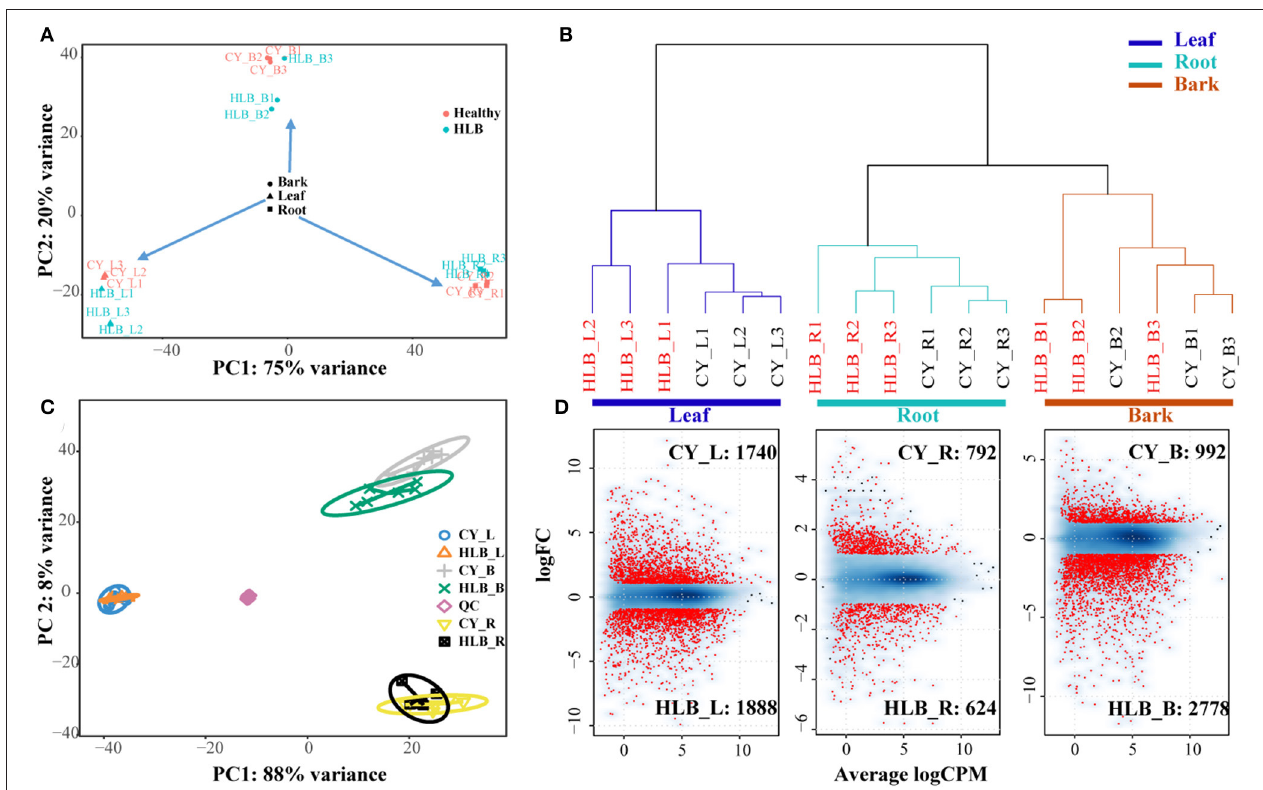
FIGURE 2 | Cluster analysis of all the differentially expressed genes (DEGs) and detected metabolites between C Las-infected and healthy tissues. (A) Principal component analysis (PCA) analysis of all the samples based on all the expressed genes; (B) Hclust analysis of all the samples based on all the expressed genes; (C) sPLS-DA analysis of all the samples based on all of the metabolites; (D) analysis of DEG detection: a smooth scatter was used to convert the number of points in each plot coordinate into a vector of colors representing the local point